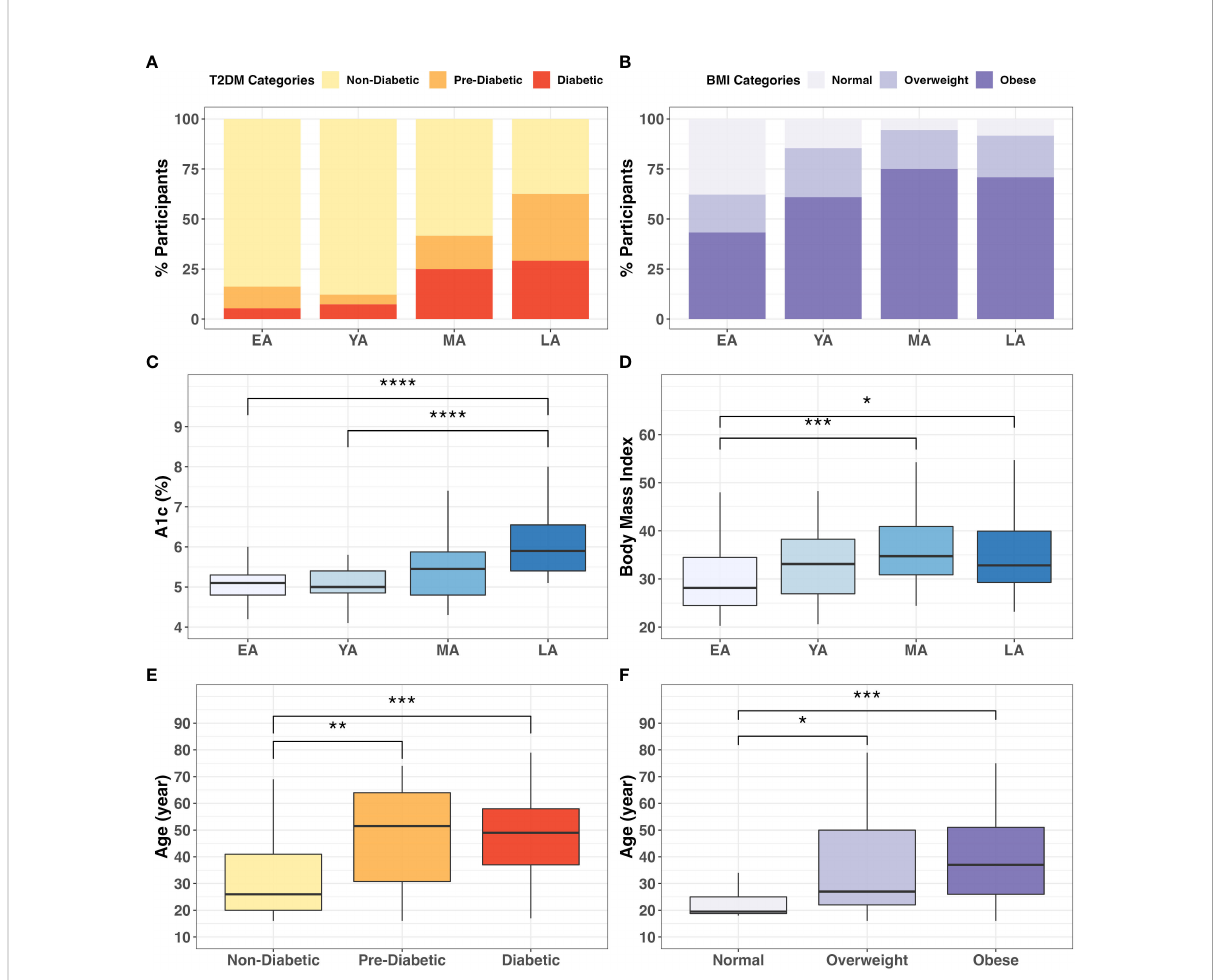
FIGURE 3 Categorical associations between age, T2DM, and BMI. The proportion individuals in the cohort in (A) T2DM ( X 2 = 27.6; P<0.001 ) and (B) BMI categories (X 2 = 17.8; P<0.001) varied signi fi cantly across age groups. Intergroup comparison demonstrated signi fi cantly different (C) A1c (P<0.0001) and (D) BMI (P=0.005) values across age groups. Additionally, participant age signi fi cantly differed across (E) T2DM (P<0.001) and (F) BMI (P=0.001) categories. * = P<0.05; ** = P<0.01; *** = P<0.001; ****= P<0.0001